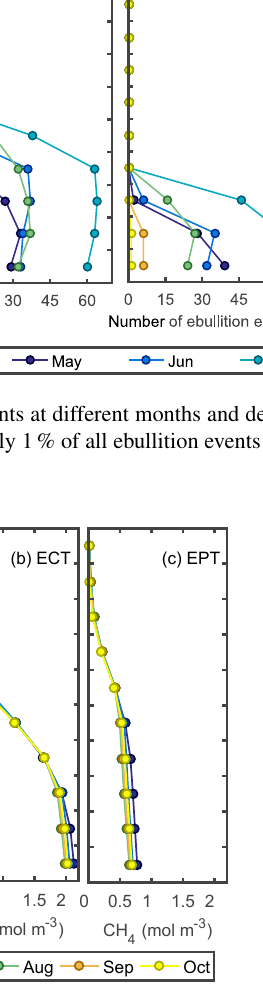
Figure 2. Average CH 4 pore water concentrations at different depths and months.